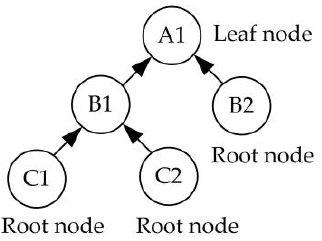
Figure 5. The Bayesian network directed acyclic graph.